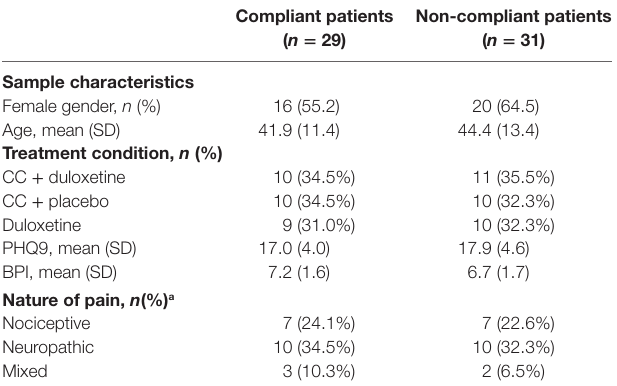
TaBlE 2 | Gender, age, treatment condition, depressive and pain symptoms, and nature of pain at baseline of compliant ( n = 29) and non-compliant ( n = 31)